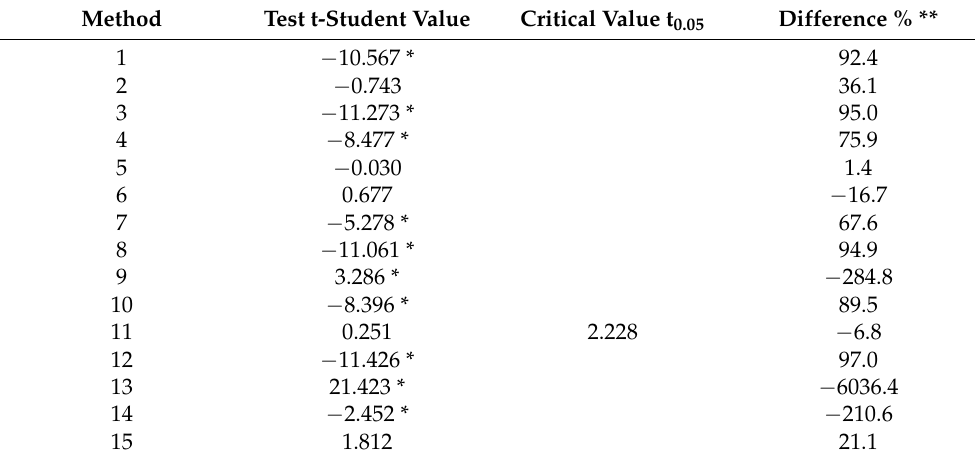
Table 6. Values of t-Student test between results obtained by means of the pedotransferfunctionswith- the ones obtained by means of measured